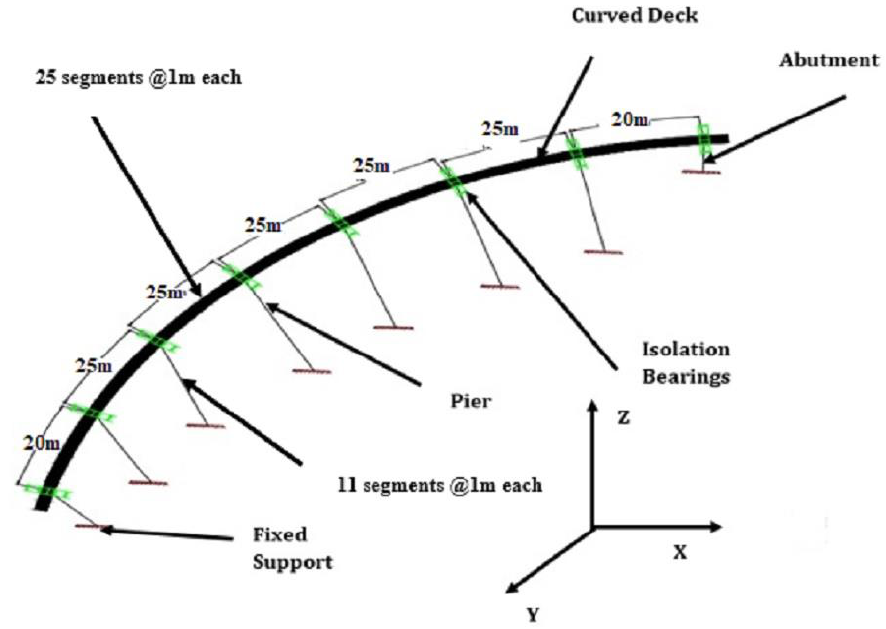
Figure 2. Curved bridge considered for the study.